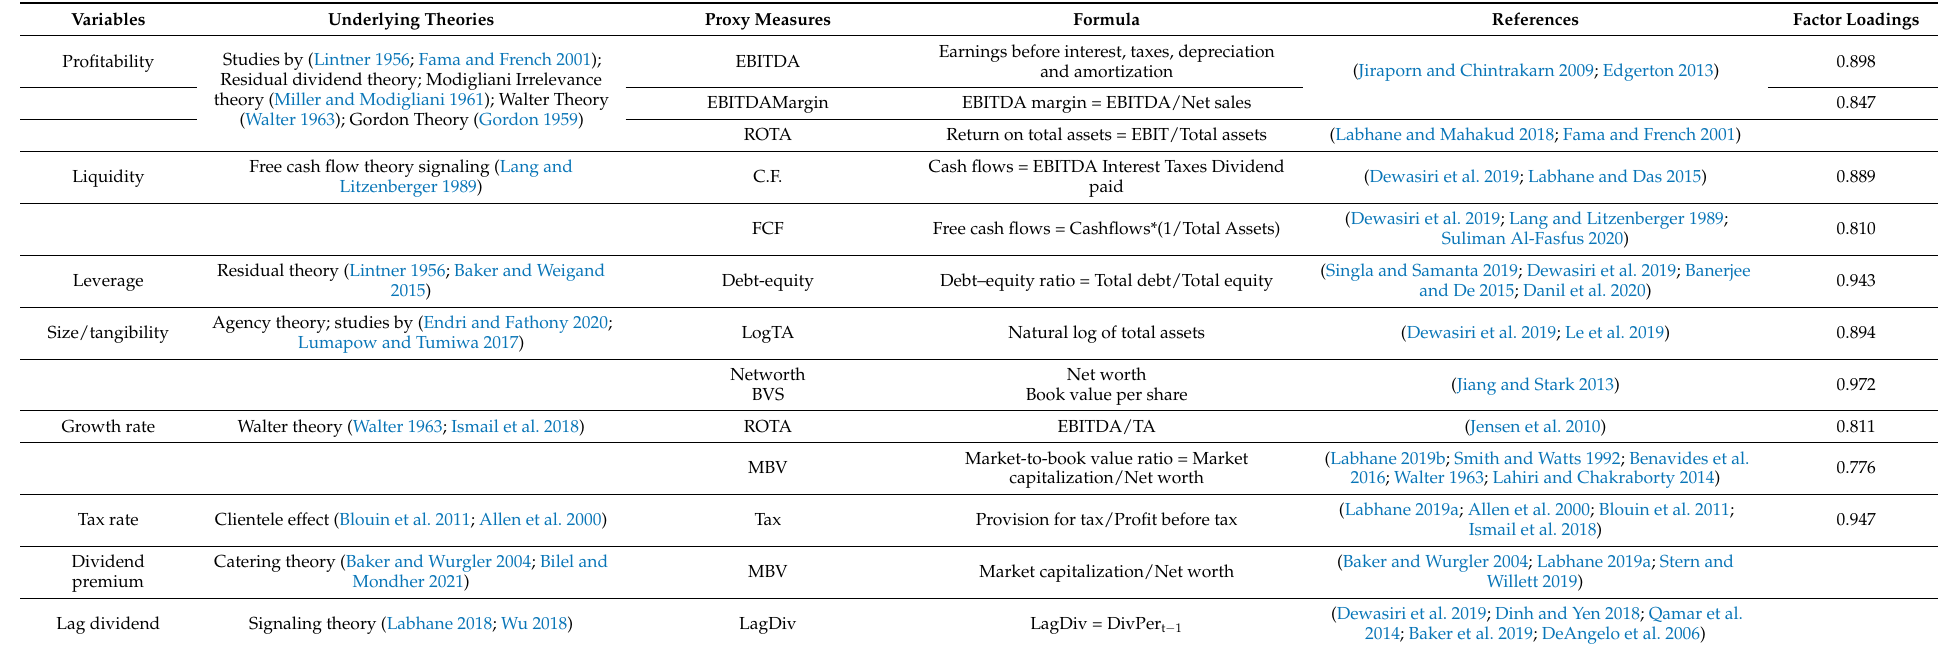
Table 1. Independent variables used in the